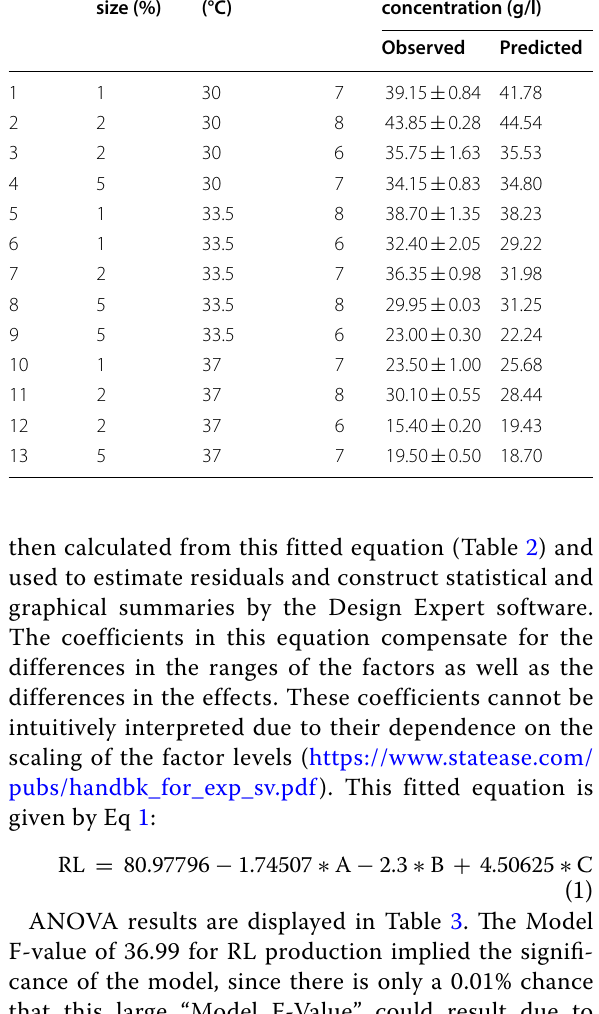
Table 2 Experimental Box–Behnken design (BBD) with the actual values of the independent factors inoculum size (A), temperature (B) and pH (C) and the observed and predicted responses Run no. Inoculum size (%)